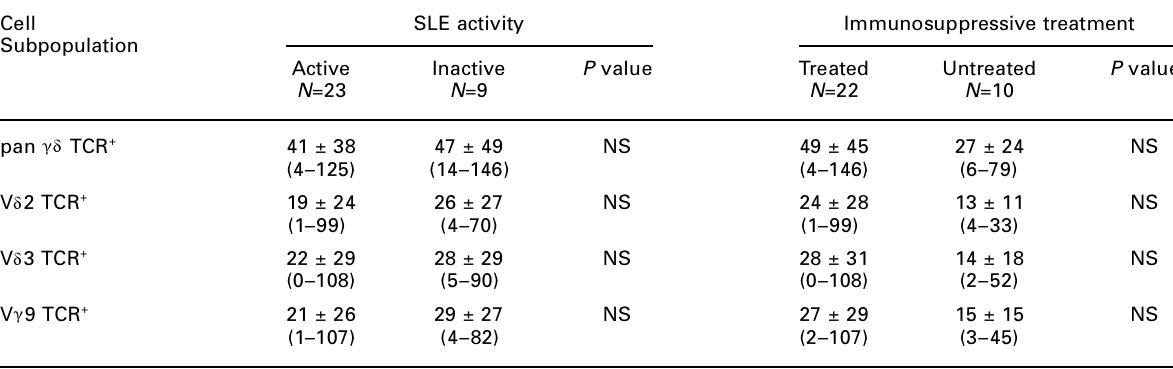
Table 4. The frequency of g d T cell subtypes in peripheral blood of patients with SLE dependent on disease activity and immunosuppressive treatment (mean of cells number/ m l ± SD and range in parentheses) Cell